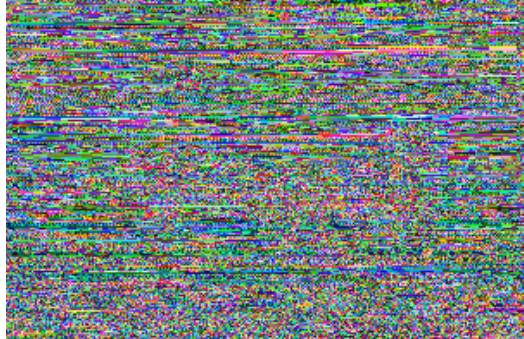
Figure 16. Decryption effect when the key entered is